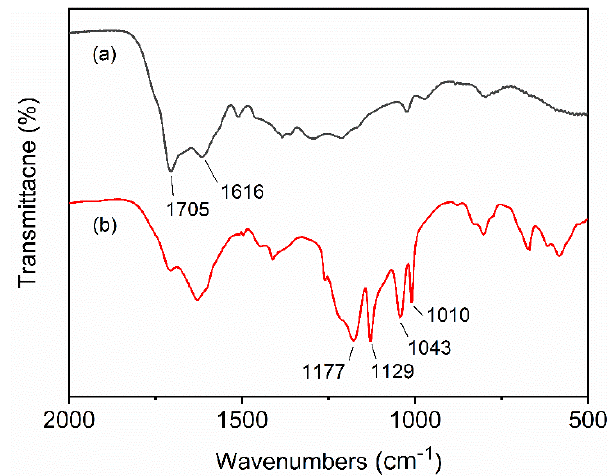
Figure 3. Fourier-transform infrared spectrometry (FTIR) spectra of the ( a ) CS and ( b ) ASPB.